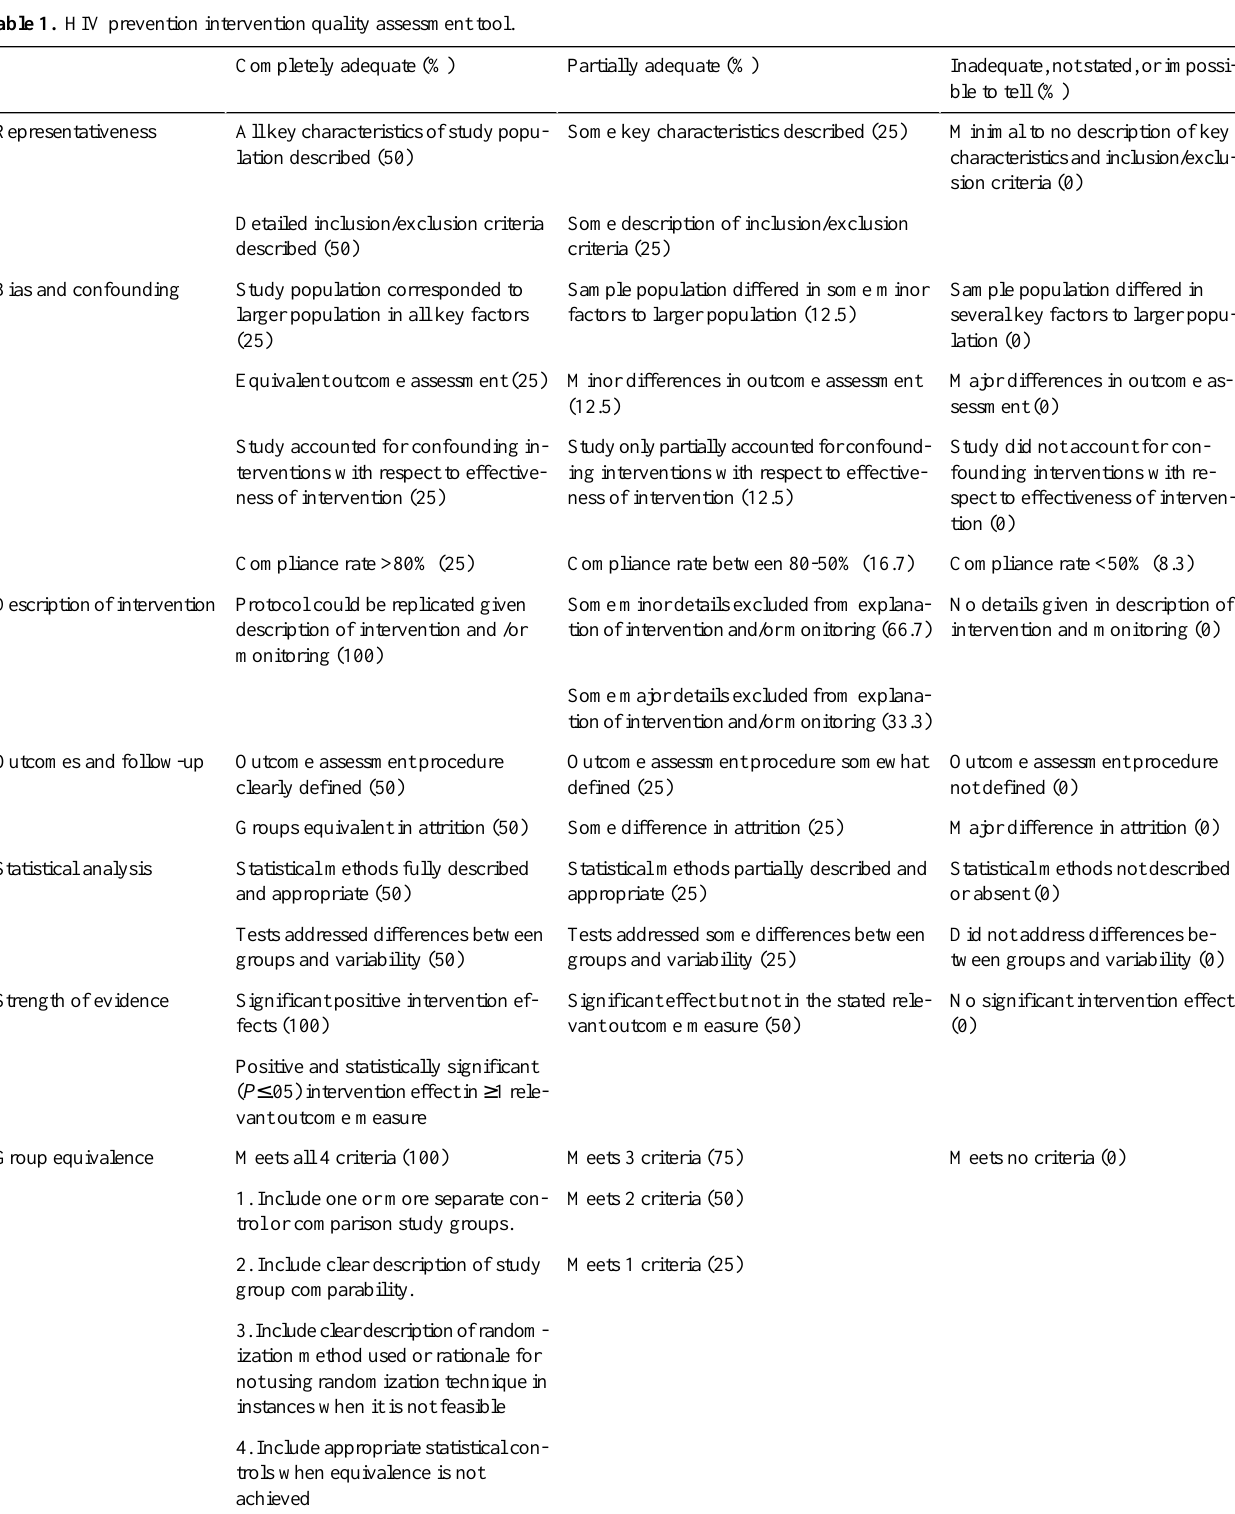
Table 1. HIV prevention intervention quality assessment